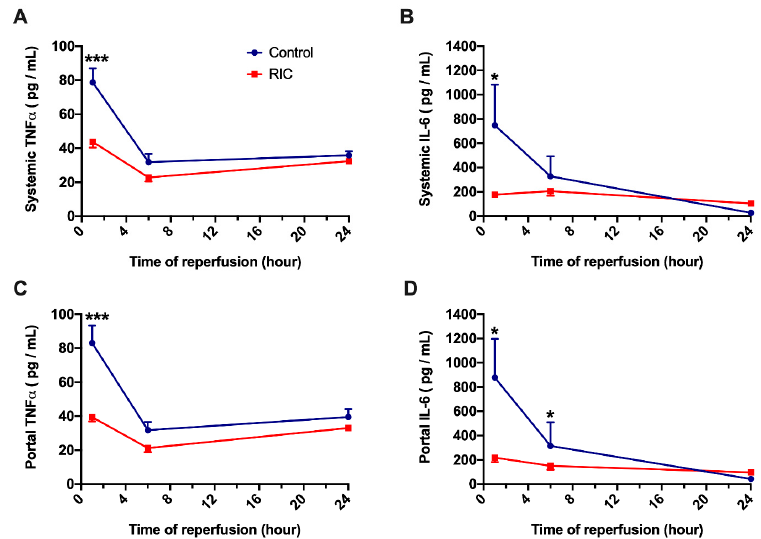
Figure 4. Portal and systemic levels of inflammatory cytokines. No major differences were found between the portal and systemic levels of proinflammatory serum cytokines (TNF α and IL-6). Systemic serum TNF α and IL-6 were significantly elevated in the early phase or reperfusion (1-h) ( A , B ). The application of iRIC resulted in a significant decrease of both inflammatory cytokines. Similar changes have been observed in TNF α and IL-6 levels of the portal blood ( C , D ) (mean ± s.e.m., * p < 0.05, *** p < 0.001 RIC vs. Control, two-way ANOVA and Bonferroni post-hoc test, n = 5 / group /